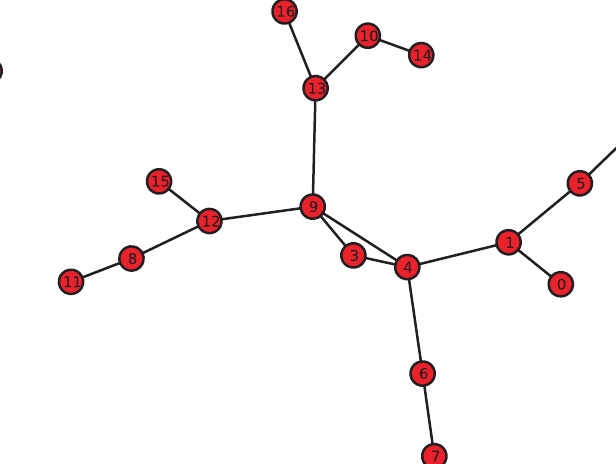
Figure 2. I orb versus I l